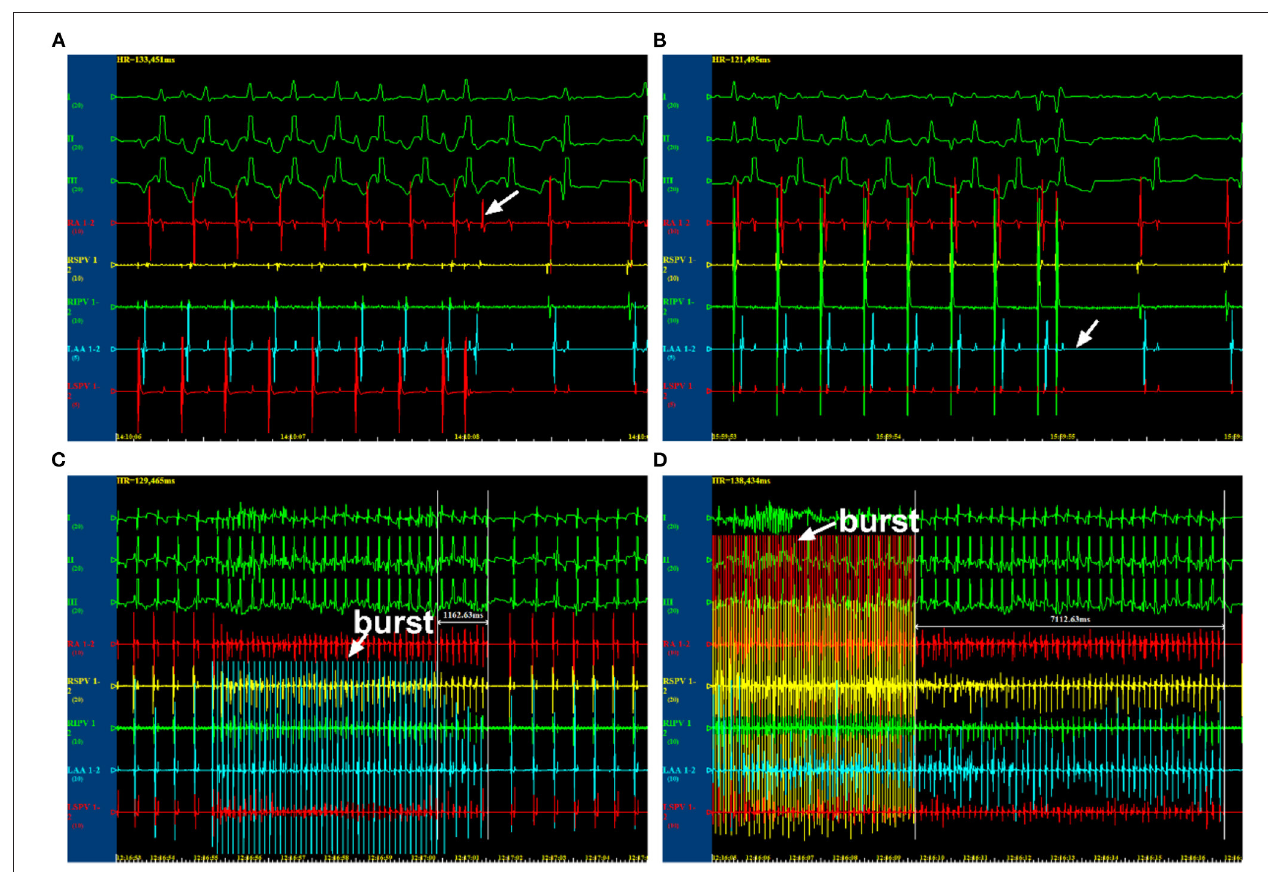
FIGURE 1 | Electrophysiological examination by programmed stimulations. (A) The state at which AERP was not reached. (B) The state at which AERP was reached. (C) The state at which atrial fibrillation (AF) was unable to be induced. (D) The state at which AF was induced. AERP, atrial effective refractory